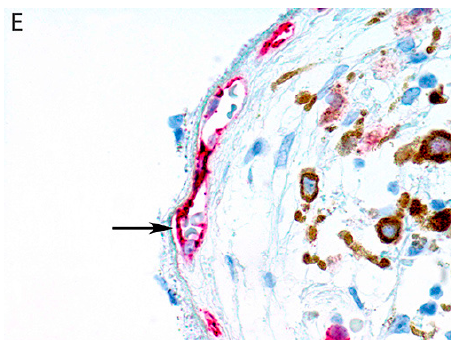
Figure 1. Sample 8 of Table 2: peritumoral focal positive staining of choriocapillary vasculature for lymphatic vessel endothelial hyaluronic acid receptor-1 (LYVE-1). The staining pattern of the five markers are shown (arrows). ( A ) Cluster of differentiation 31 (CD31) stains all endothelial cells. ( B ) Podplanin (D2-40) is negative. ( C ) LYVE-1 shows focal positive staining in a vessel of the choriocapillaris. ( D ) Prospero-related homeobox gene-1 (Prox-1) is negative. ( E ) CD34 stains all endothelial cells. (All panels: original magnification 400×).